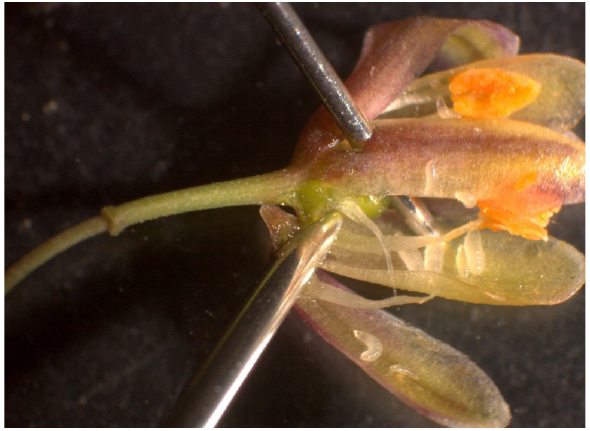
Figure 9. Number of stems infested with Prodiplosis longifila and healthy stems in the UC-157-F1 cultivar asparagus field.